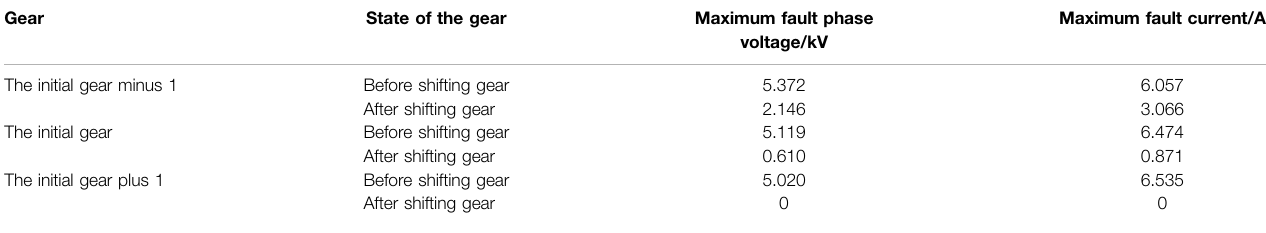
TABLE 3 | Comparison of the voltage and current of the fault phase before and after the adjustment of the gear position in different gear positions.